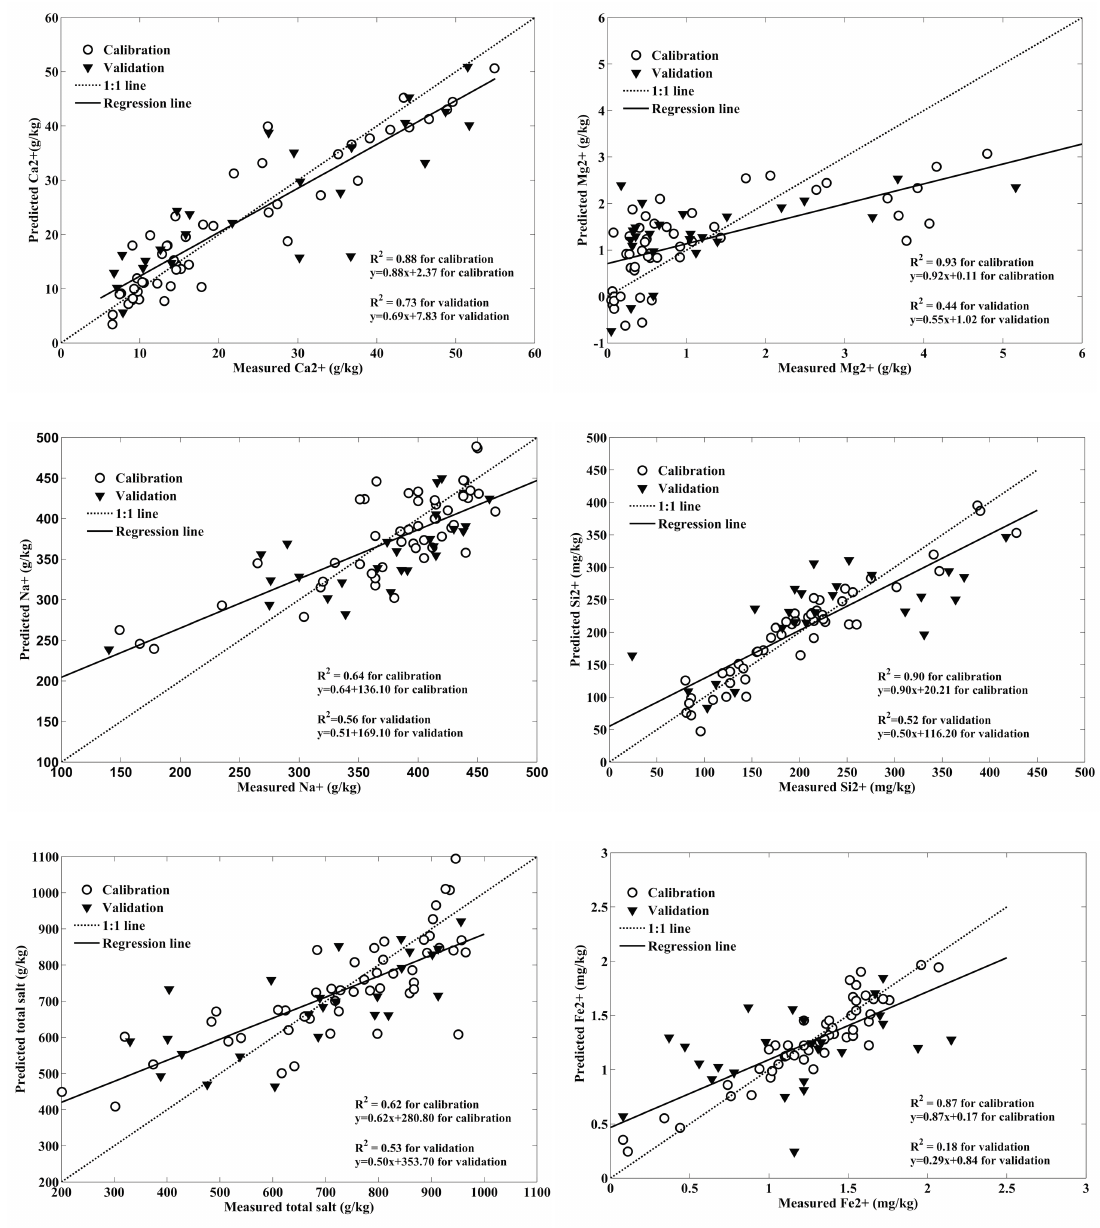
Figure 2. Scatter plots for measured salt-crust properties and PLS estimates using laboratory